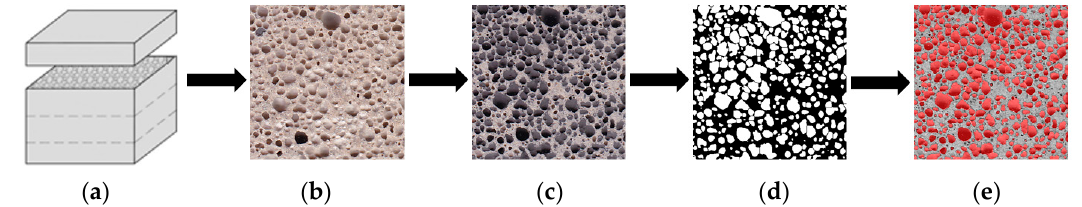
Figure 1. Diagram for determining the cross-sectional distribution of air pores. ( a ) Original cross- section; ( b ) scanned specimen surface; ( c ) paint applied to specimen surface; ( d ) scanned image converted to binary image to calculate pore size and area; ( e ) air pores highlighted in cross section.